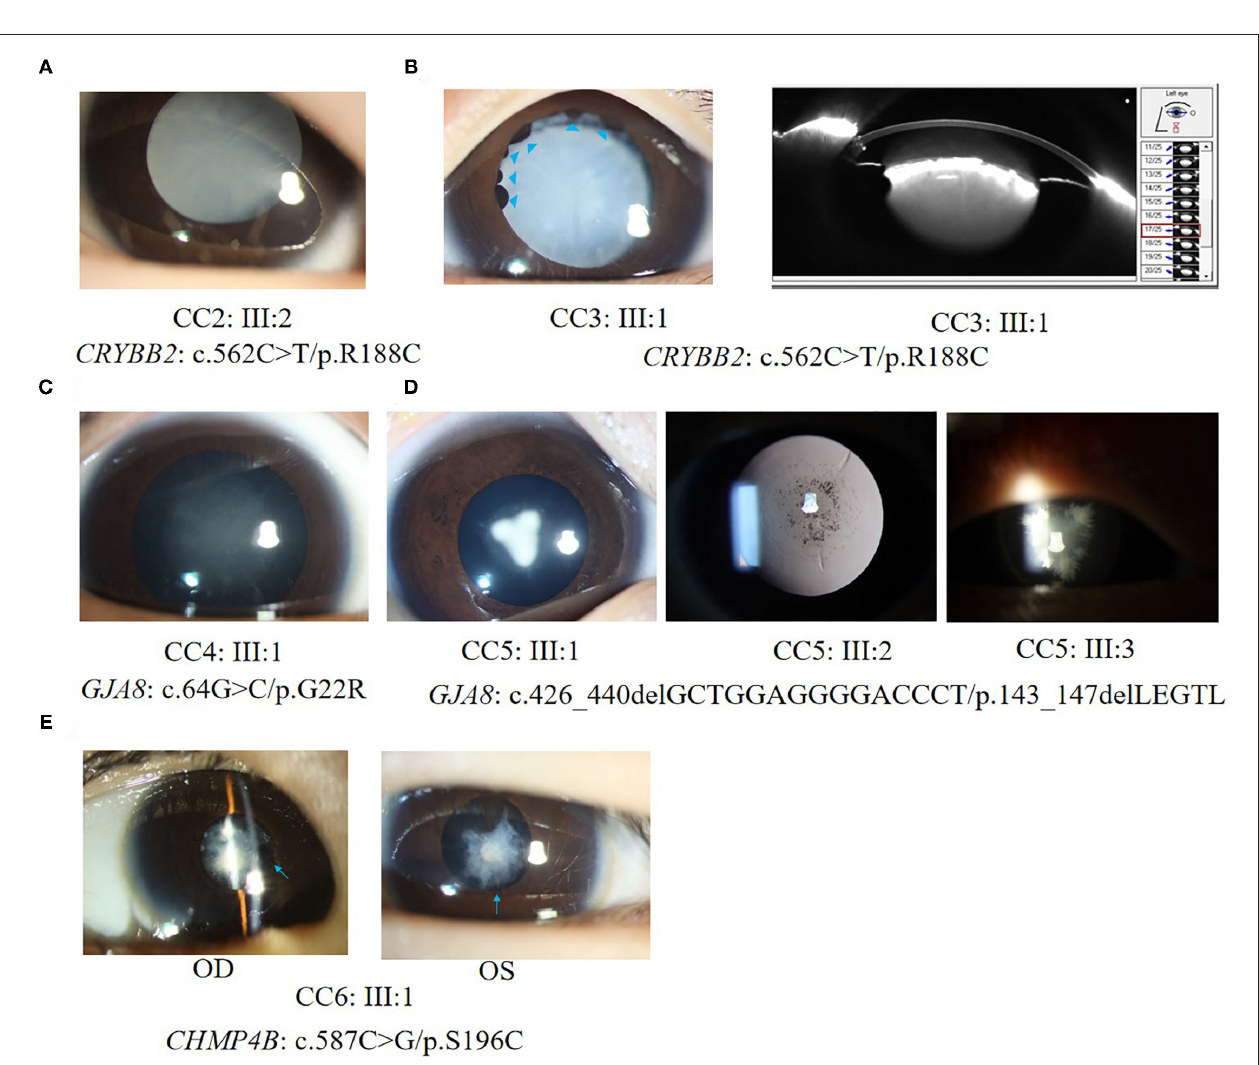
FIGURE 2 | p.143_147del LEGTL, and CHMP4B : S196C) are located within highly conserved regions (blue dashed box). (B) Structure homology modeling and comparison of mutant protein and native β B2-crystalline protein, Cx50, and the chromatin-modifying protein 4b (pink dashed box). The secondary structure was shown with α -helixes, β -sheets and loops in hydrophobic color scheme. From purple to red shows the least hydrophobic residues to most hydrophobic residues. (a) In the missense CRYBB2 : p.R188C, the substitution replaces a basic arginine residue with an uncharged cysteine residue at the surface of the β B2-crystalline protein; (b) In the missense GJA8 : p.G22R, a buried uncharged glycine residue mutants to a charged arginine residue, which located at the first transmembrane region of Cx50; (c) The small deletion GJA8 : p.143_147delLEGTL locates at the cytoplasmic loop of the Cx50 protein, close to the third transmembrane domain; (d) The CHMP4B :